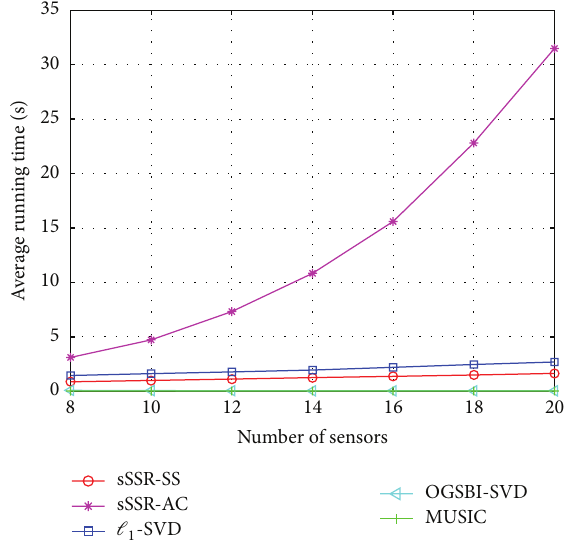
Figure 6: The average running time of ℓ 1 -SVD, OGSBI-SVD, MUSIC, sSSR-AC, and sSSR-SS with respect to the number of the sensors 𝑀